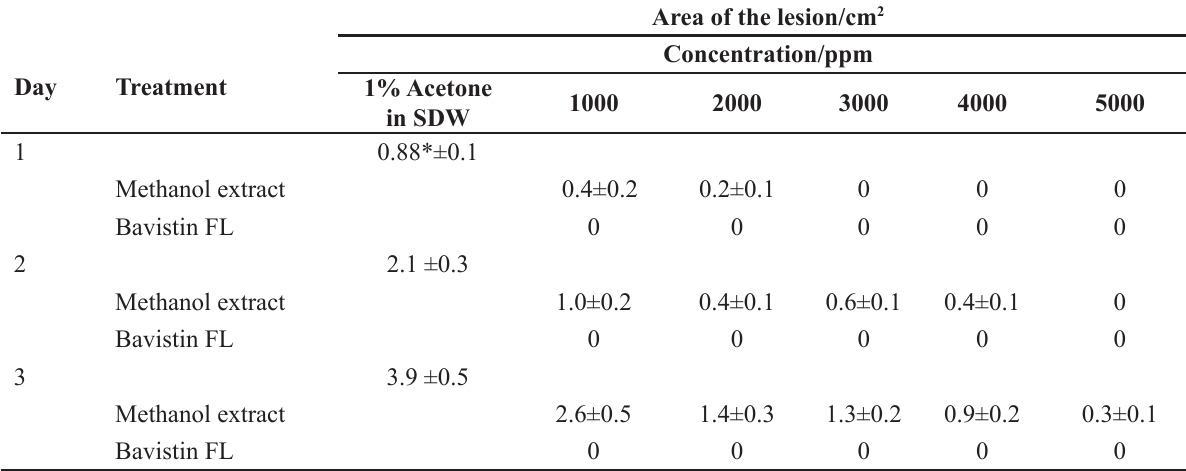
Table 2: Effect of the methanol extract of A. riparia on anthracnose development.